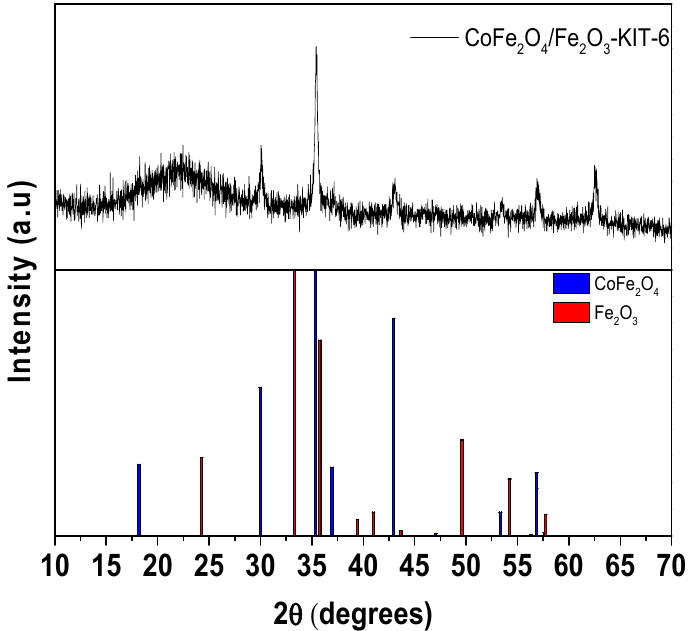
Figure 11. The XRD of CoFe 2 O 4 /Fe 2 O 3 -KIT-6 catalyst after photocatalytic degradation reaction.